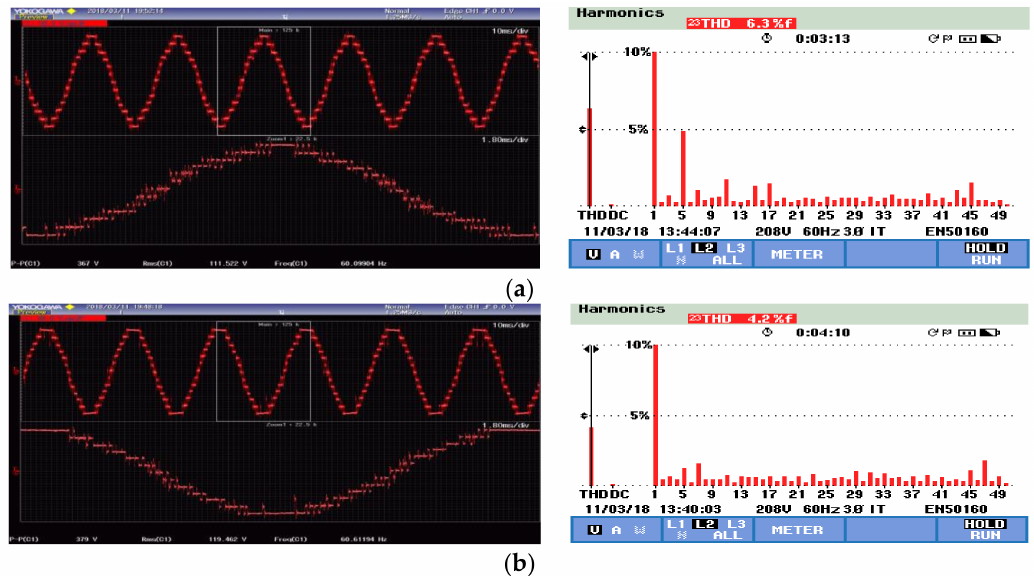
Figure 11. Output voltage and FFT results for a ( a ) Sinusoidal PWM; and ( b ) THI-PWM.